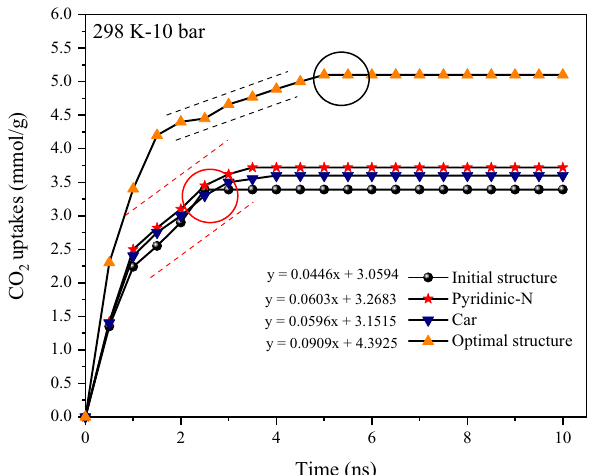
Figure 9. Comparison of gas adsorption kinetics in different conditions (at 298 K under 10 bar). The circles (Black-Red) drawn in the diagram show the starting point of saturation.